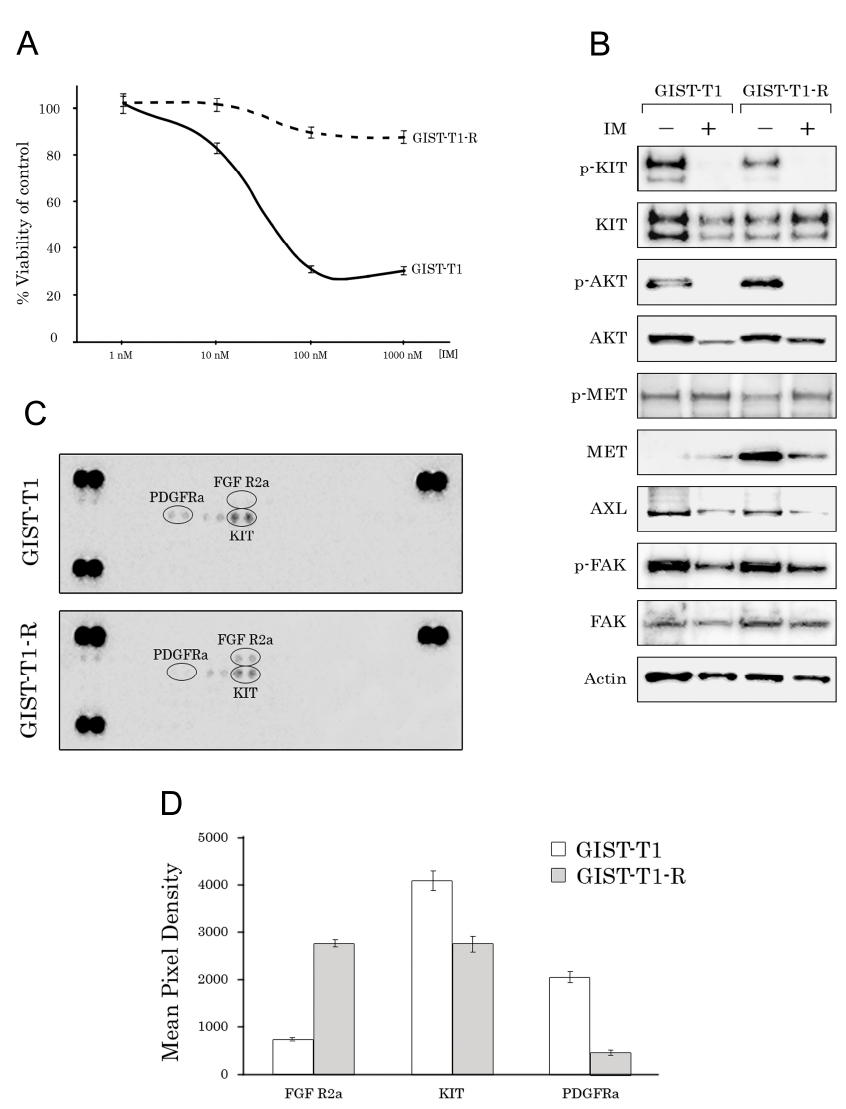
Figure 1. ( A ) MTS-based viability assay in IM-treated GIST-T1 vs. GIST T-1R (R, resistant) cells. Cells were treated with the indicated concentrations of IM and assessed after 48 h of treatment, with the data normalized to DMSO-treated controls. Values are the means ± standard deviation (n = 3); ( B ) Immunoblot evaluations of KIT, AKT, MET, AXL and FAK in non-treated ( − ) and IM-treated (+) GIST T-1 and GIST T-1R cells. Actin stain is a loading control; ( C ) Total cell lysates (300 µ g) from GIST T-1 (upper panel) and GIST T-1R cells (lower panel) were analyzed by the phospho-RTK array. Each RTK was spotted in duplicate, and the spots at each corner are positive controls; ( D ) Quantification by mean pixel density revealed that the phosphorylated proteins are dysregulated in GIST T-1R vs. parental GIST T-1 cells.